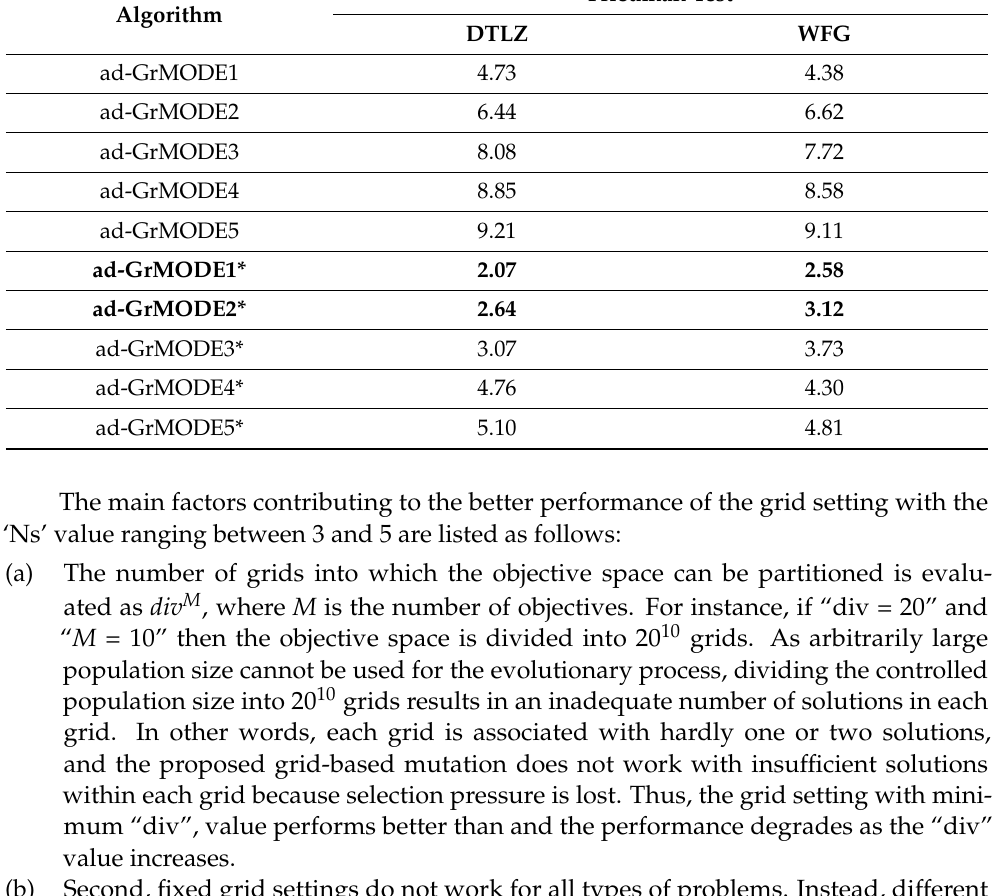
Table 3. Friedman test ranking results of different grid settings on DTLZ and WFG problems.